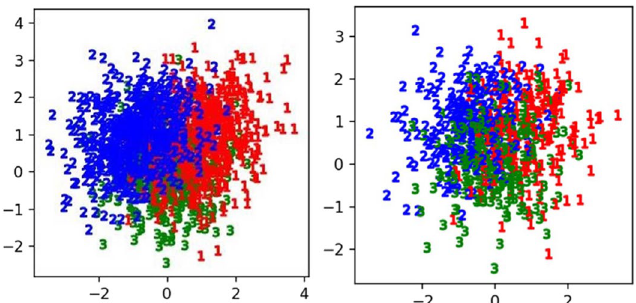
Fig. 4 The distribution of the instances in the artificial data set Gaussian1 (left), and the distribution of the instances selected from the artificial data set Gaussian1 (right)